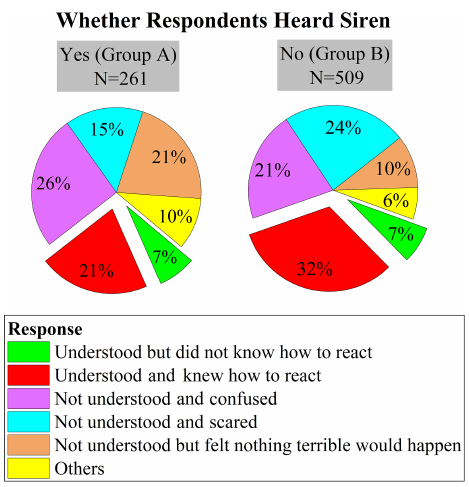
Figure 2. Public responses to the siren/broadcast speaker of early warning for the Changning earthquake from an internet-based sur- vey in Chengdu,